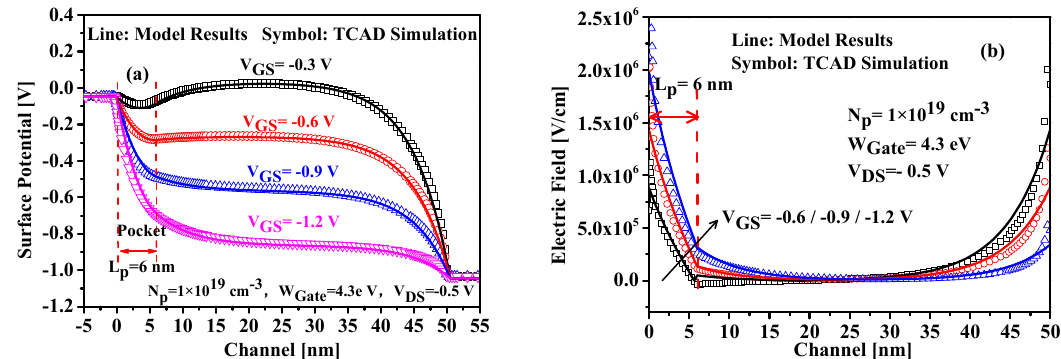
Figure 4. Variation of ( a ) the surface potential and ( b ) the lateral electric field with V GS .